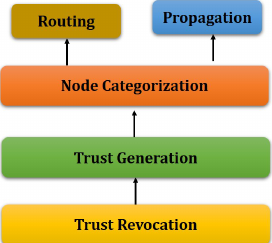
Figure 1. The trust model